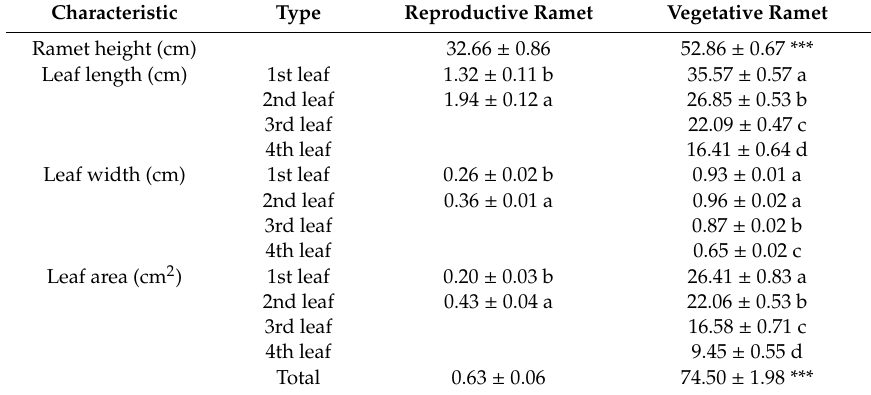
Table 1. Morphological characteristics of reproductive ramets and vegetative ramets in the